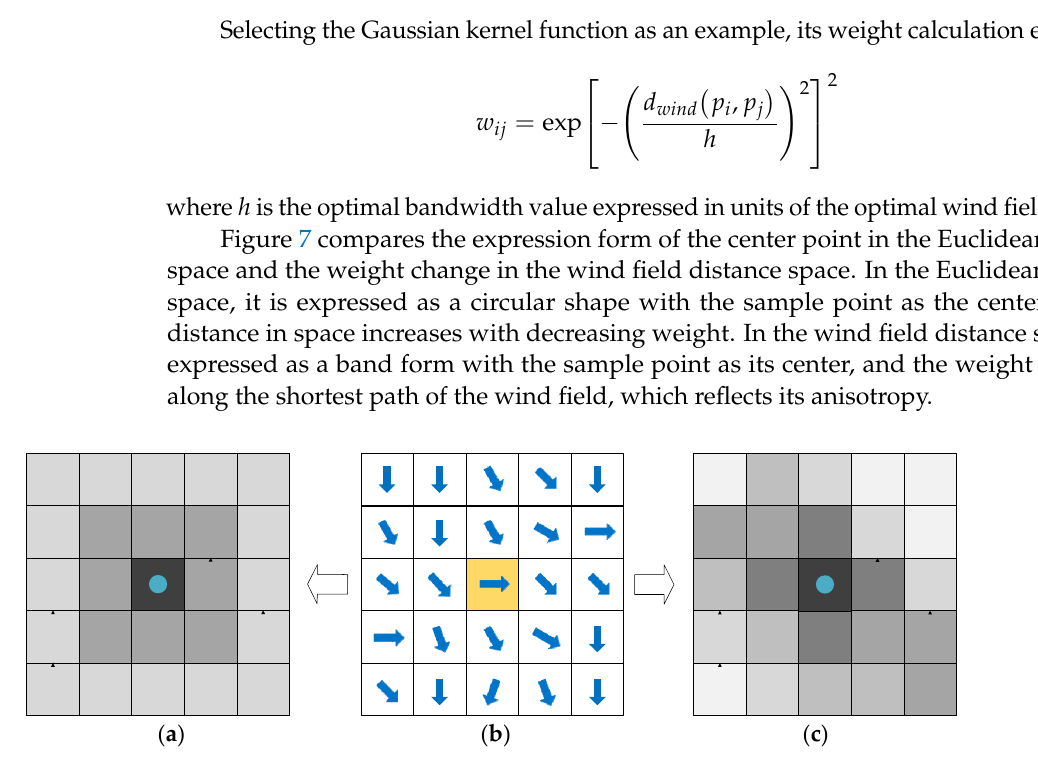
Figure 7. Representation of weighted kernel function in wind field space ( b ): ( a ) spatially constrained, ( c ) directionally and spatially constrained [35].